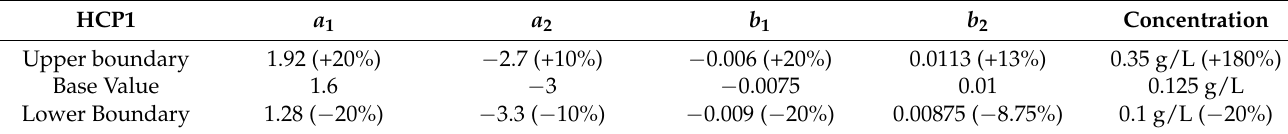
Table 2. HCP1 parameter boundaries for the dataset generation.